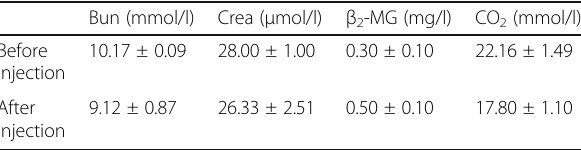
Table 1 The effect of AuNS@PEG nanoparticles on BUN, Crea, β 2 -MG, and CO 2 levels before and after injection of AuNS@PEG nanoparticles in rat ( n =